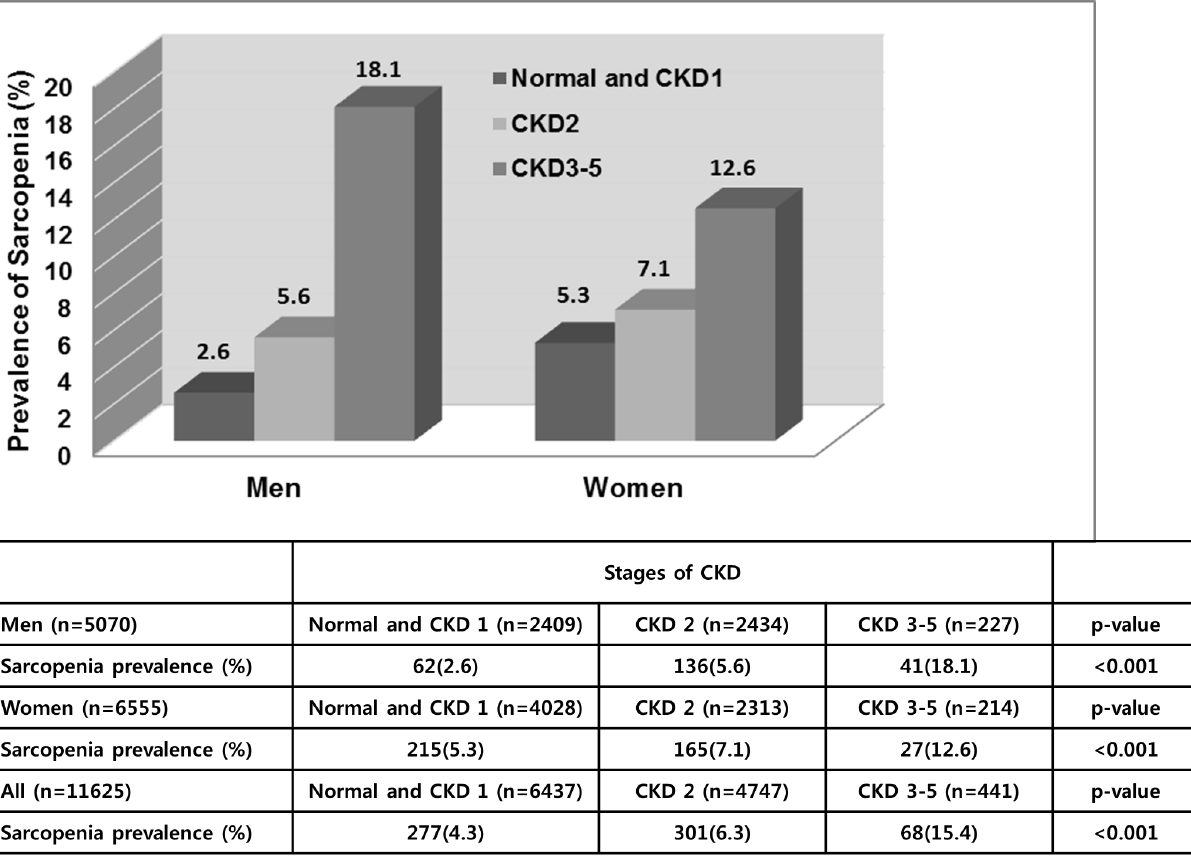
Fig 1. Prevalence of sarcopenia according to chronic kidney disease